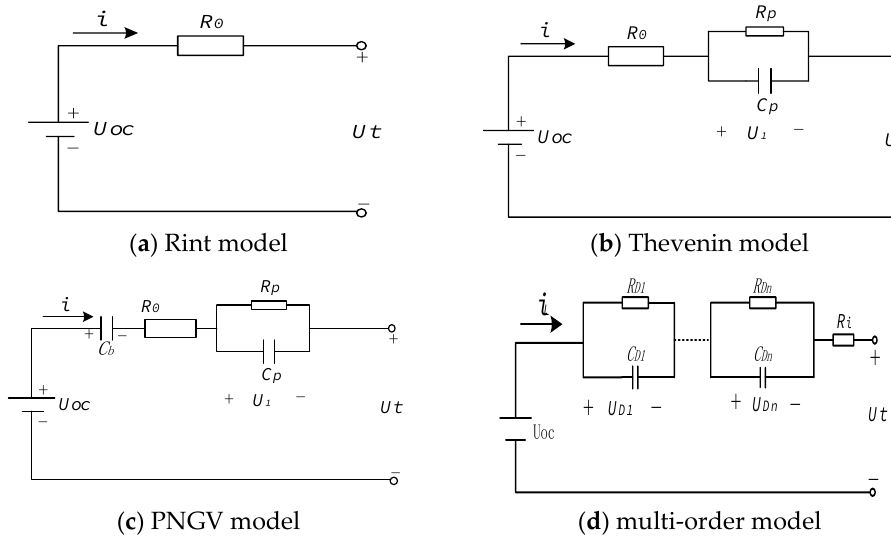
Figure 1. Common integer-order equivalent circuit models.